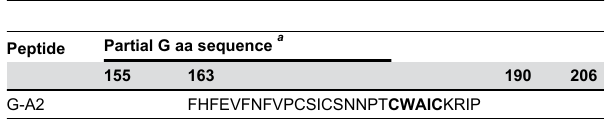
Table 1. The RSV G-A2 peptide sequence and location of the CX3C motif in the G protein.